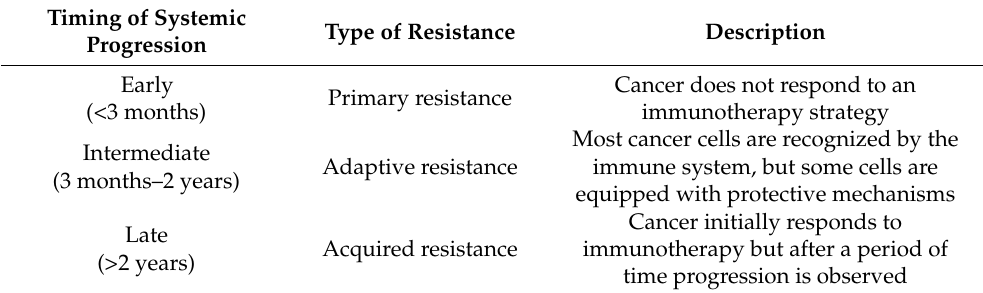
Table 1. The short summary of three different types of resistance to immunotherapy [7]. Timing of Systemic Type of Resistance Progression